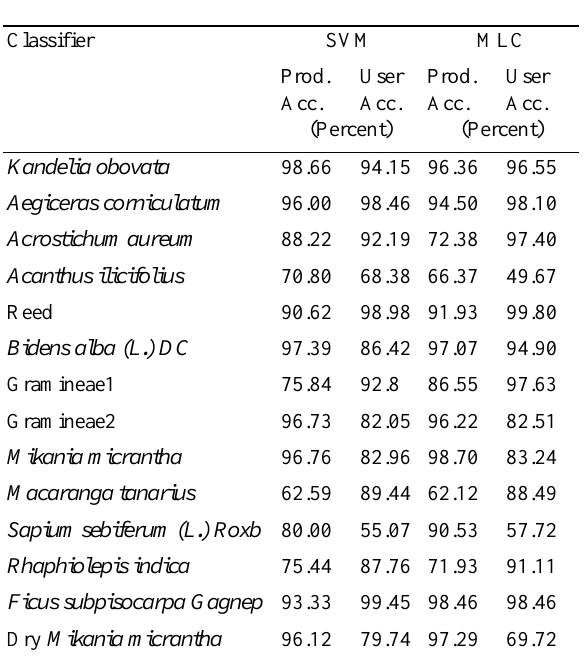
Table 3. Producer and user accuracy for each class using MNF 20 components and DSM as